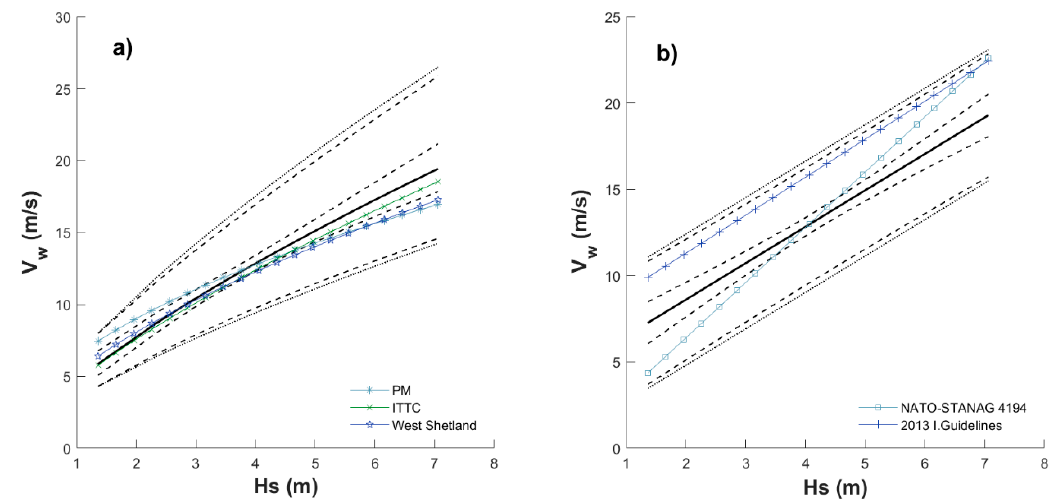
Figure 11. Regression lines and confidence intervals including (solid and dashed lines, respectively) and excluding (dashed–dotted and dotted lines, respectively) T -yr values for August; ( a ) and ( b ) for logarithmic space and linear space, respectively. Filled circles represent T -yr values with embedded perpendicular lines indicating confidence intervals from GEV models.